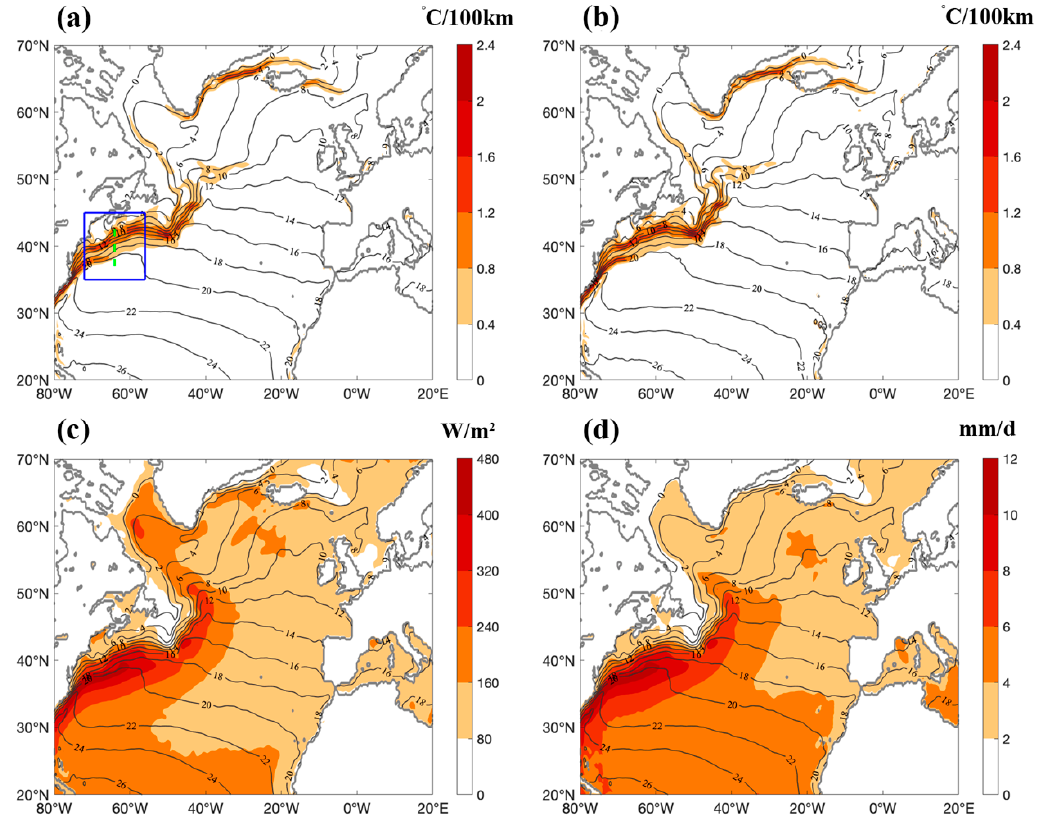
Figure 1. Mean sea surface temperature (SST) gradient across the front between 1981 and 2019 in winter months (November to March, NDJFM) in the Gulf Stream extension region from ( a ) NOAA OISST (Optimum Interpolation Sea Surface Temperature) ( ◦ C / 100 km) and ( b ) ERA5 SST ( ◦ C / 100 km). ( c ) Mean turbulent heat flux during 1981–2019 (W / m 2 ). ( d ) As in (c) but for evaporation (mm / d). Contours are mean SST during 1981–2019. The blue box in ( a ) marks the region (35 ◦ N–45 ◦ N, 72 ◦ W–56 ◦ W) used to calculate the regional averaged SST time series in Figure 2. The green line shows the section used to plot the SST profile in Figure 2.